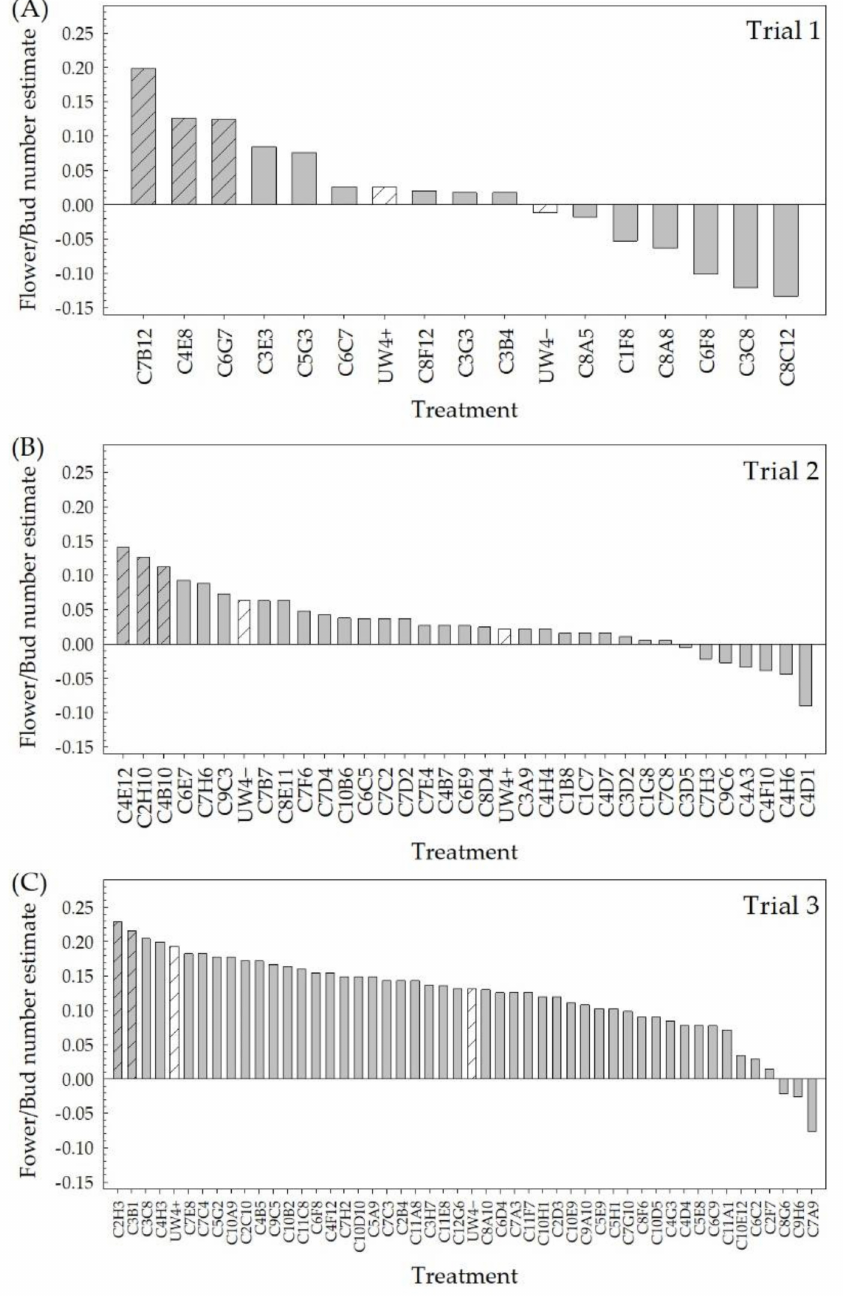
Figure 1. The number of flowers and buds (open flowers plus flower buds) of Petunia × hybrida ‘Picobella Blue’ treated with bacterial isolates from a greenhouse rhizosphere collection grown under low-fertility conditions (25 mg L − 1 N) in the high-throughput greenhouse trials. Flower/bud number was counted 6 weeks after transplant. The 94 isolates were evaluated in three different groups, trial 1 ( A ), trial 2 ( B ), and trial 3 ( C ) ( n = 12). Estimates of the treatment effect compared to the negative control (no bacterial treatment) from the Poisson or quasi-Poisson regression model were ranked. Positive values indicate strains that performed better than the negative control, whereas negative values indicate those that performed worse. Pseudomonas putida UW4+ and UW4 − that were included as checks are represented by white bars with slanted lines. The top 10% of the total strains were then selected from this ranking (gray bars with slanted